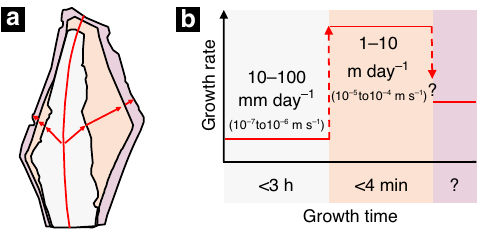
Fig. 8 Cartoon depicting how crystal growth rates may have changed from core to rim. a A sketch of the CL zonation of the crystal.